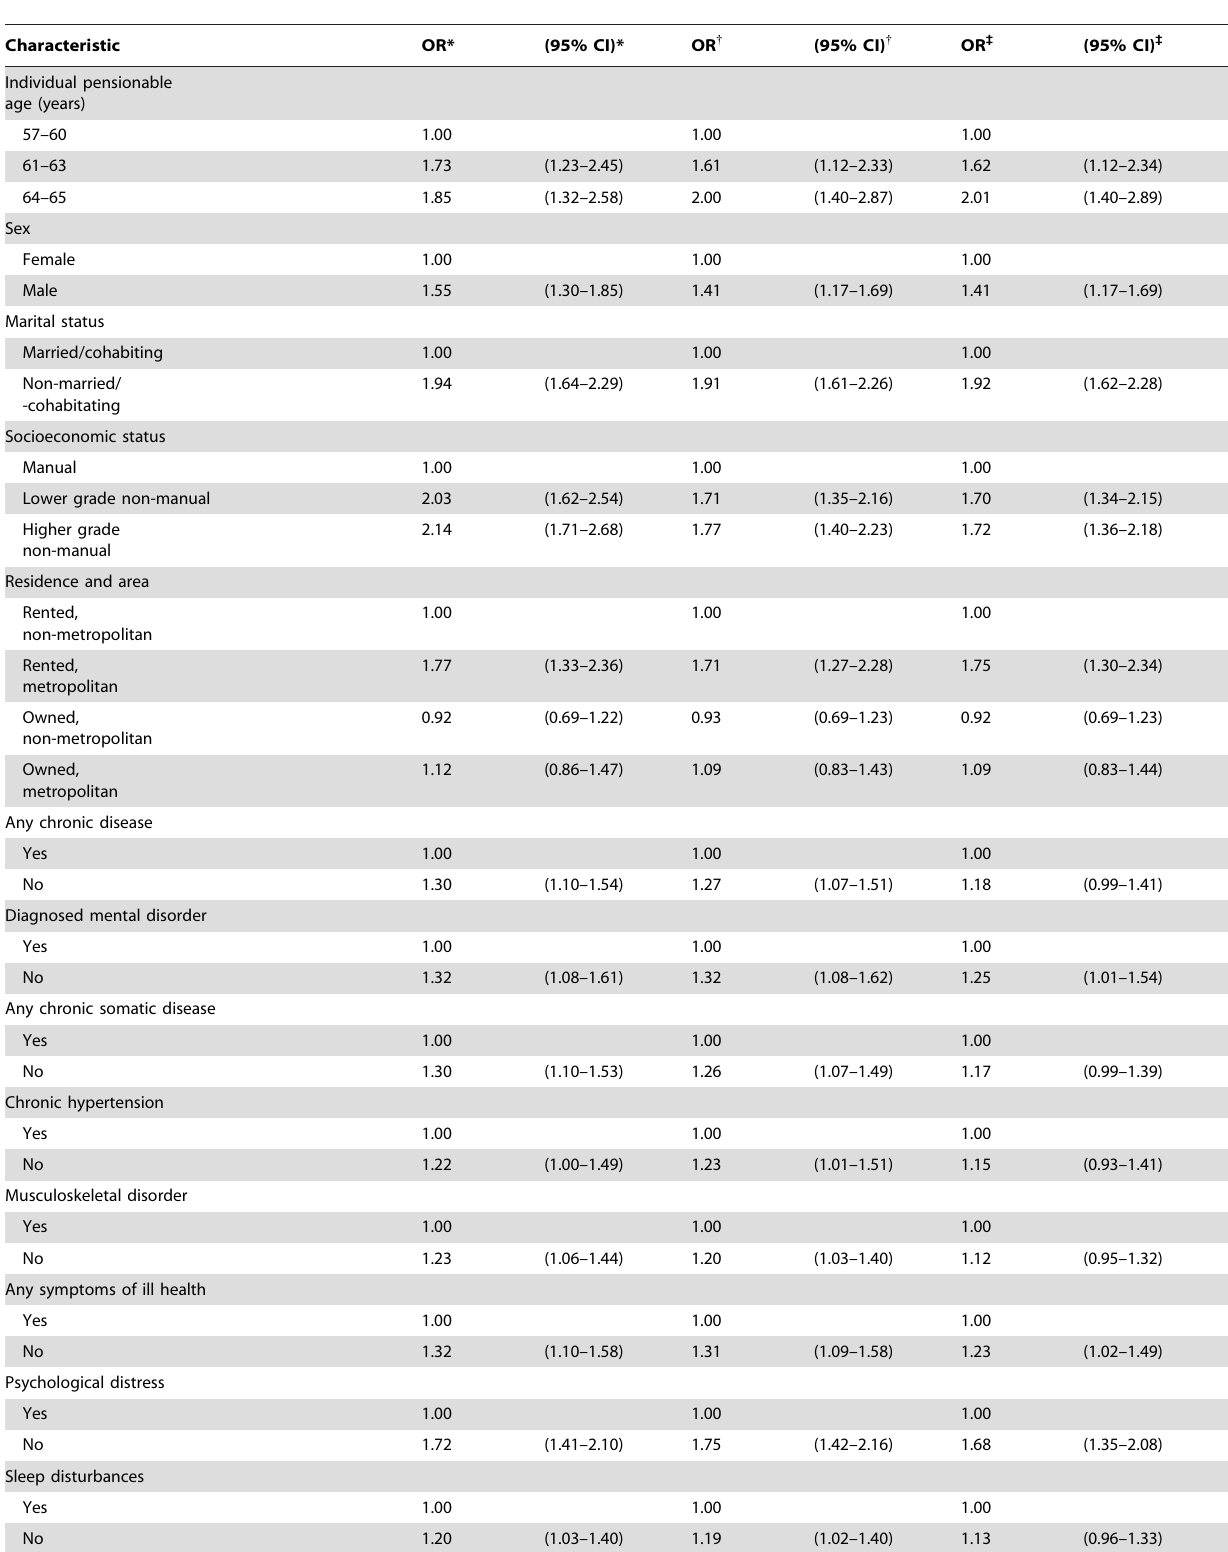
Table 1. Serially adjusted baseline characteristics associated with extended employment at . 6 months beyond the pensionable